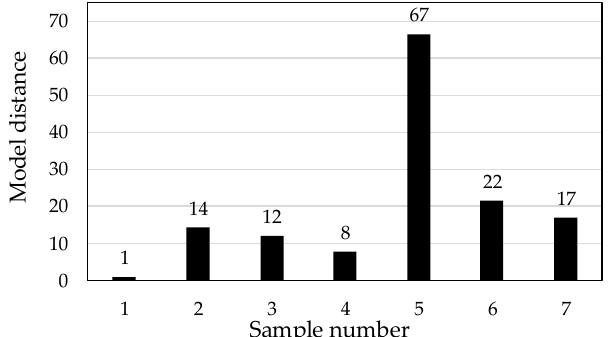
Figure 4. Model distance results of SIMCA for each sample ( α = Figure 4 . Model distance results of SIMCA for each sample ( α = 0.05).